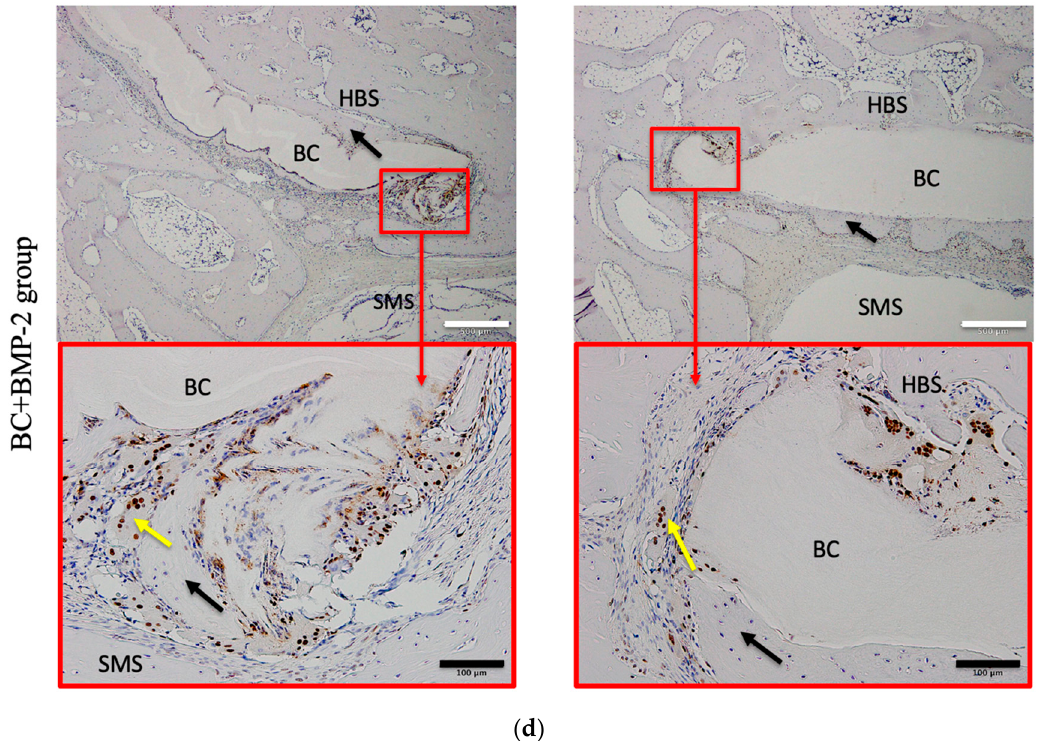
Figure 5. Immunohistochemical staining of PCNA expression in the ( a ): sham (n = 3), ( b ): BC (n = 3), ( c ): BMP-2 (n = 3), and ( d ): BC+BMP-2 (n = 3) groups at four and eight weeks. Blue arrows indicate connective tissue, black arrows indicate newly formed bone, and yellow arrows indicate cartilage tissue. HBS, host bone side; SMS, sinus membrane side; BC, bacterial cellulose. White scale bars (500 μ m) indicate slices at 4× magnification; black scale bars (100 μ m) indicate slices at 20× magnification.